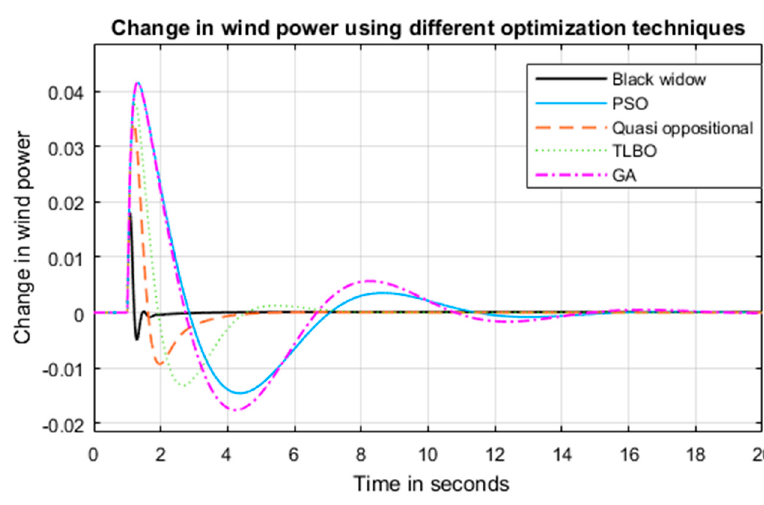
Figure 12. Change in wind power using di ff erent optimization